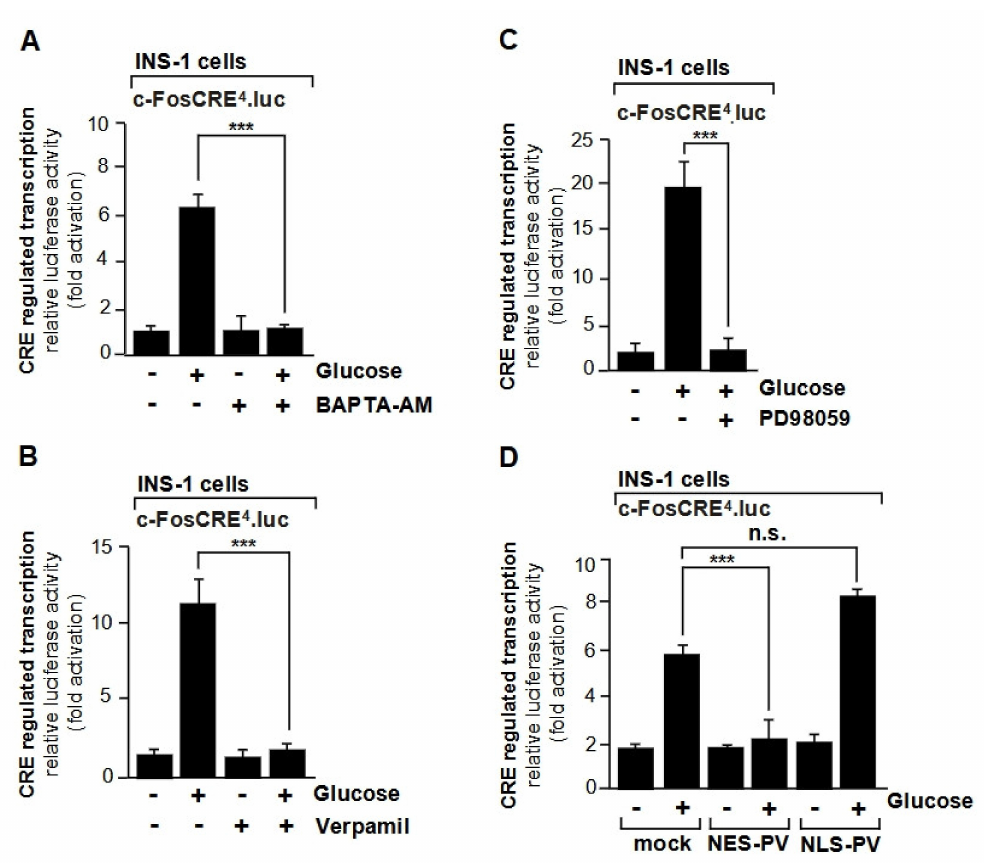
Figure 3. Increased CRE-regulated transcription in glucose-stimulated insulinoma cells requires a rise in cytosolic Ca 2+ . ( A , B , C ) INS-1 insulinoma cells expressing a chromatin-embedded CRE-responsive reporter gene (c-FosCRE 4 .luc) were maintained in serum-free medium containing 2 mM glucose for 24 h and then stimulated with glucose (11 mM) for 48 h. Cells were cultured in the presence or absence of the Ca 2+ chelator BAPTA-AM (A), the L -type Ca 2+ channel inhibitor verapamil (50 µ M) ( B ), or the MAP kinase kinase inhibitor (PD98059) ( C ) as indicated. Cell extracts were prepared and analyzed for luciferase activities. Luciferase activity was normalized to the protein concentration. The compound PD98059 blocks phosphorylation of the MAP kinase kinase by Raf, and thus inhibits the ERK1/2 signaling pathway. ( D ) INS-1 insulinoma cells expressing a chromatin-embedded CRE-responsive reporter gene (c-FosCRE 4 .luc) were infected with a lentivirus encoding either mCherry as control, NES-PVmCherry, or NLS-PVmCherry, triggering expression of a parvalbumin-mCherry fusion protein either in the cytosol (NES-PVmCherry) or in the nucleus (NLS-PVmCherry). The cells were maintained in serum-free medium containing 2 mM glucose for 24 h. Stimulation with glucose (11 mM) was performed for 48 h. Cell extracts were prepared and analyzed for luciferase activities. Luciferase activity was normalized to the protein concentration. Data shown are means +/ − SD of at least three experiments performed in quadruplicate (*** p < 0.001). Reproduced with modifications from ref. [48] with permission from